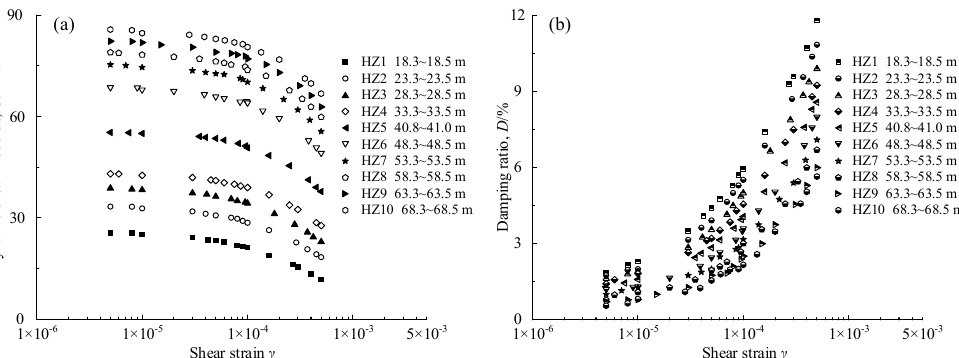
Figure 3. Experimental results of RC tests on marine clay from Bohai Bay: ( a ) variation of dynamic shear modulus with shear strain; ( b ) variation of damping ratio with shear strain.